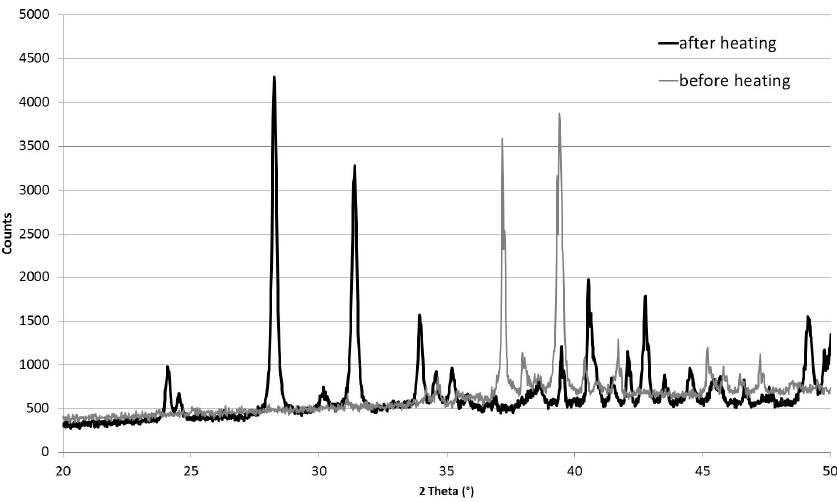
Figure 1. X-ray powder diffraction (XRD) diffractogram of the Cu 10 Zr 7 sample before and after heating up to 1373 K.